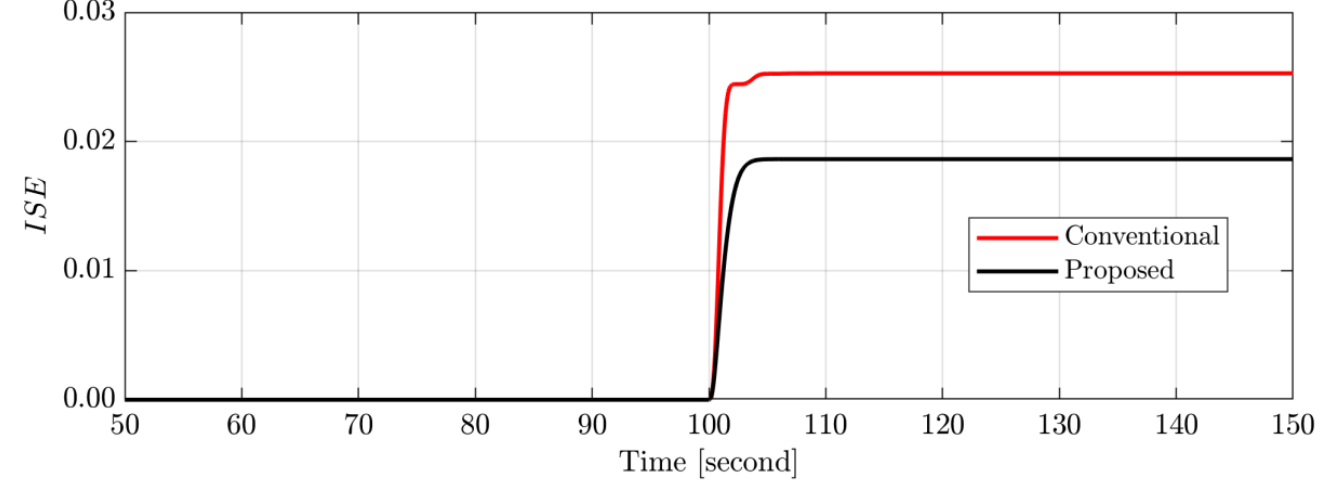
Figure 10. The ISE objective functions of the studied system for the case 1.